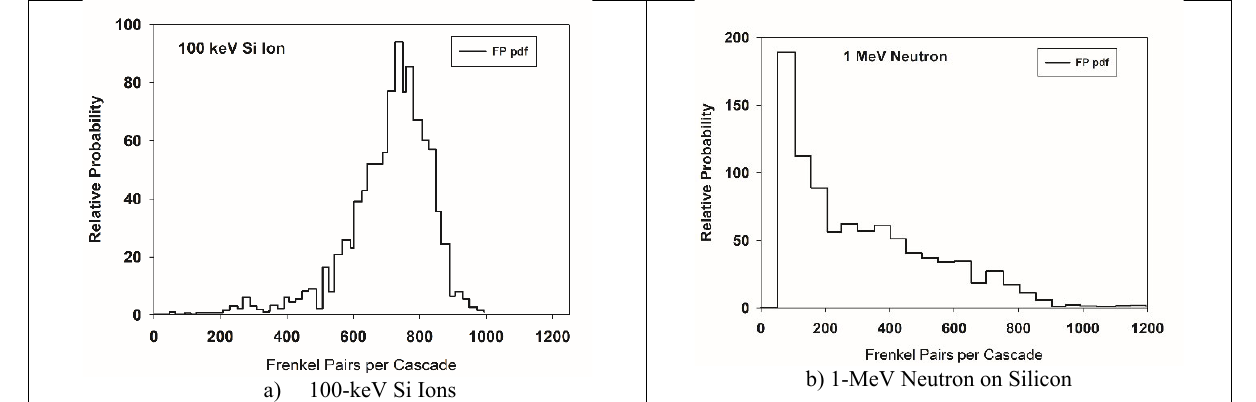
Fig. 14. Probability distributions for the number of Frenkel pairs